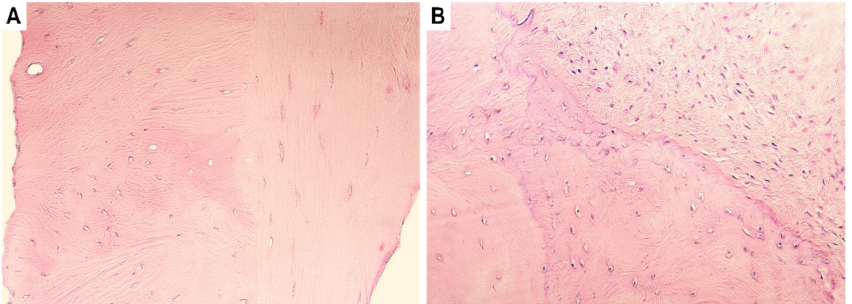
Figure 1. Routinely stained hematoxylin and eosin slides (H&E). ( A ) Note the chaotic